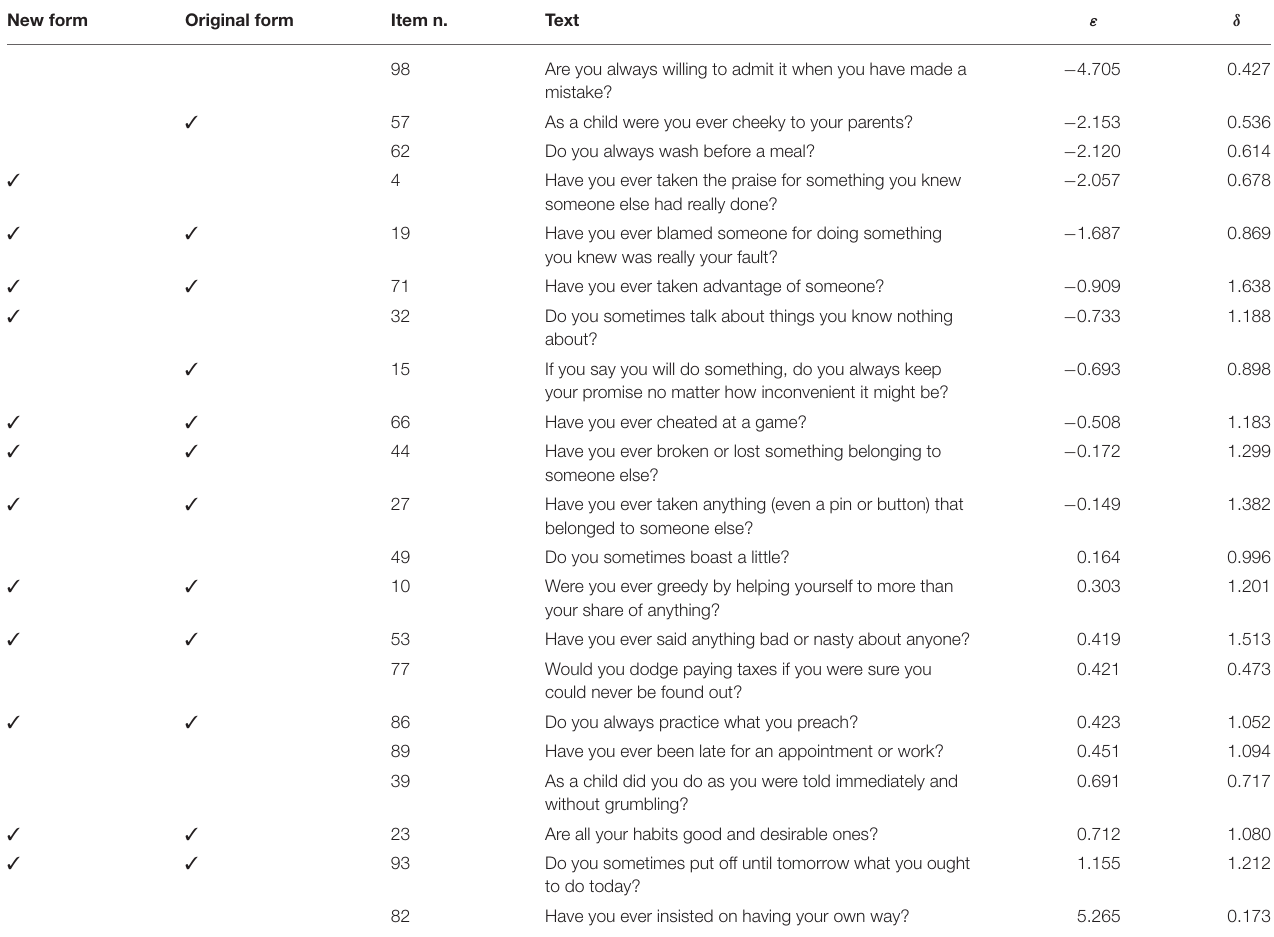
TABLE 4 | Easiness ( ε ) and discrimination ( δ ) parameters for the 21 items of the Lie scale. New form Original form Item